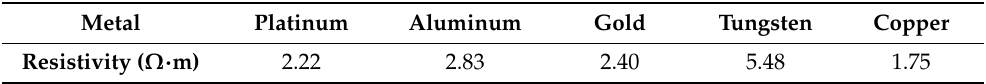
Table 1. Resistivity of some common